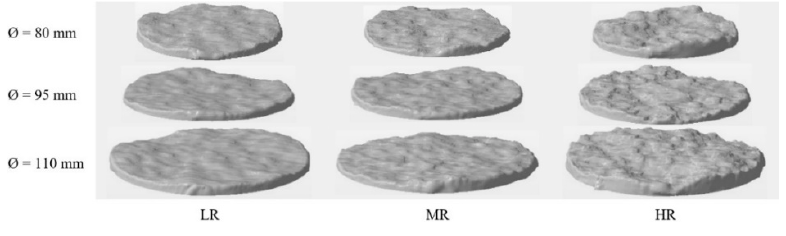
Figure 3. Surfaces of final plaster joints at three levels of